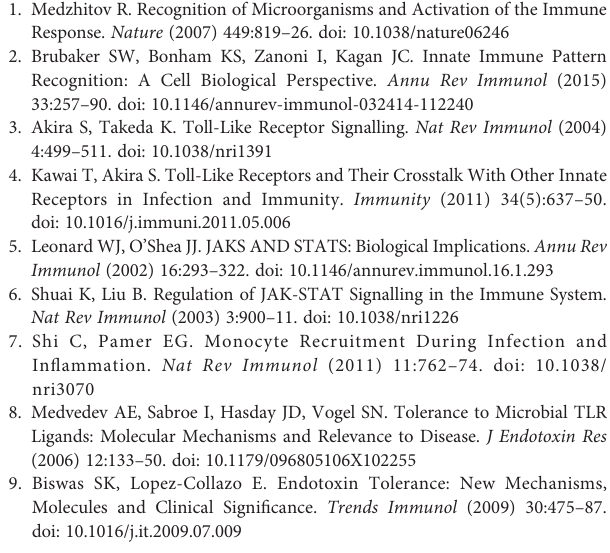
Supplementary Figure S1 | DNA methylation pro fi le of P3C-treated human CD14+ monocytes. (A) DNA methylation heatmap of differentially methylated CpGs obtained with all the possible contrasts between the represented groups ( Db - ≥ 0.2, adjusted p (FDR) < 0.05). Scaled b -values are shown, ranging from -2 (lower DNA methylation levels, blue) to +2 (higher methylation levels, red). (B) Principal component analysis (PCA) of the CpGs shown in Supplementary Figure 1A. Principal components 1 and 2 are shown. (C) Simpli fi ed scheme of TLR4 and TLR2 signaling pathways. (D) Venn diagram of differentially methylated CpGs of LPS- treated versus untreated monocytes (LPS) and P3C-treated versus untreated monocytes (P3C). (E) Scatter plots of LPS hypomethylated and P3C hypomethylated CpGs showing differential of DNA methylation of LPS-treated versus untreated monocytes (x-axis) and P3C-treated versus untreated monocytes (y-axis). Contours in blue represent a 2D kernel density estimation. The R value and p values were obtained with Person ’ s correlation. (F) ChIP-seq data of depicted histone marks were downloaded from the Blueprint database. Over-representation of CpGs in histone marks were calculated using the Fisher ’ s test. Data points with FDR < 0.05 and Odds Ratio > 5 were considered signi fi cant. (G) GO (gene ontology) over-represented categories in M2 cluster CpGs. Fold change relative to background (EPIC array CpGs) and -log10(FDR) are shown. (H) Bubble scatterplot of TF binding motif enrichment for M2 cluster CpGs. The x-axis shows the percentage of windows containing the motif and the y-axis shows the magnitude of enrichment of the motif. Bubbles are colored according to the TF family. The FDR is indicated by the bubble size (selected TF with FDR ≤ 1e-05). (I) Percentage methylation level of some selected LPS-hypomethylated CpGs as obtained by bisul fi te pyrosequencing in the LPS and P3C samples. (J) qRT-PCR analysis to validate the downregulation of TET2 by siRNA (siScramble used as control). Data are normalized relative to the RPL38 gene. (**p < 0.01). (K) Western blot depicting TET2 protein levels in LPS-treated (LPS) and untreated (Ø) monocytes. Quanti fi cation of TET2/LaminB ratio is also shown (* p < 0.05). Supplementary Figure S2 | Additional features of differentially expressed genes and associated CpGs. (A) Principal component analysis (PCA) of the 500 most variable genes. Principal components 1 and 2 are shown. (B) Gene set enrichment analysis (GSEA) of LPS-treated versus untreated (Ø) monocytes, using MSigDB hallmarks (H) as gene sets. Gene sets enriched in untreated (Ø) monocytes are shown. The running enrichment score and the normalized enrichment score (NES) are shown above the graph (FDR < 0.001). (C) Gene ontology (GO) over- representation of GO biological process categories. Fold change of LPS- downregulated genes relative to background and -log10(FDR) of the Fisher ’ s exact tests are shown. (D) Discriminant regulon expression analysis (DoRothEA) of LPS-